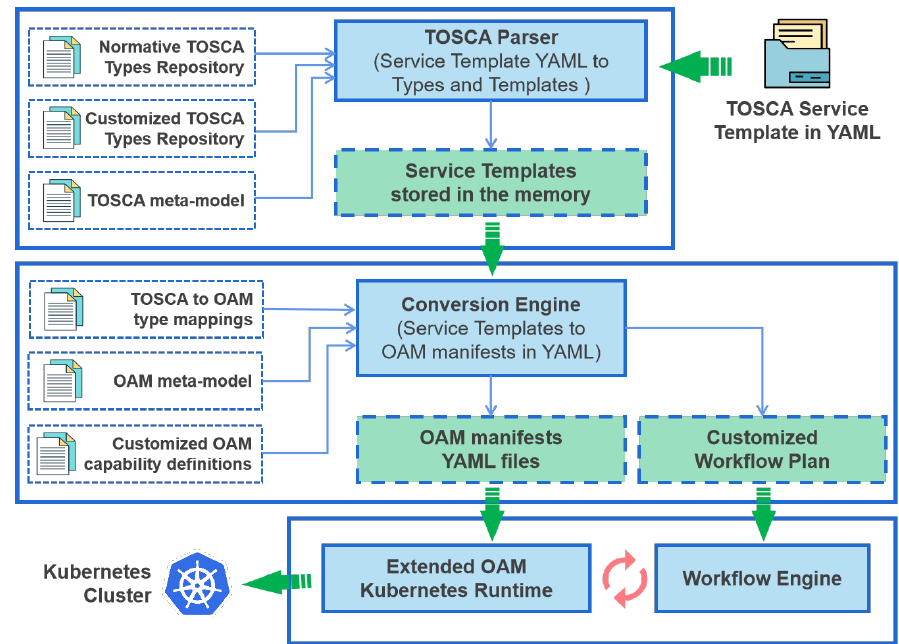
Figure 6. TOSCA-based orchestration system